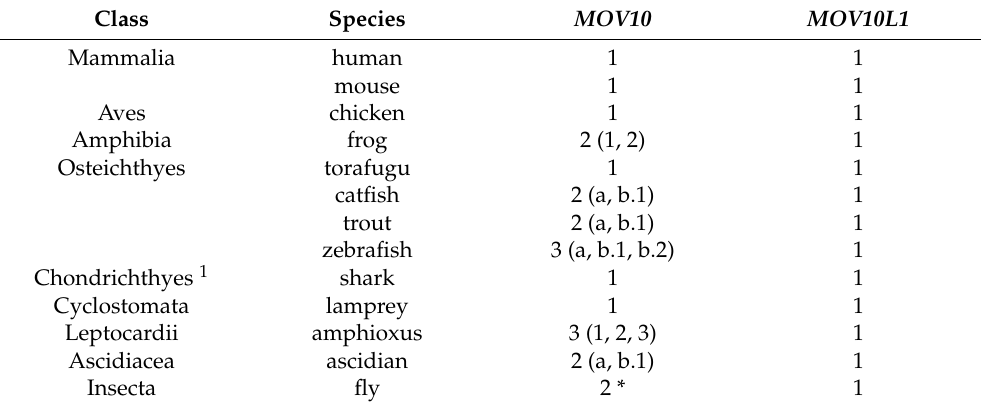
Table 2. Comparison of identified the MOV10 and MOV10L1 gene copy numbers across different representative